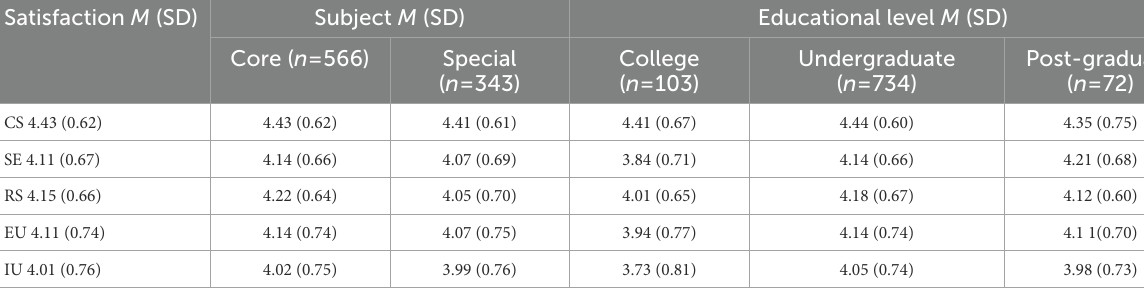
TABLE 3 Summary of Mann–Whitney U test statistic. Independent